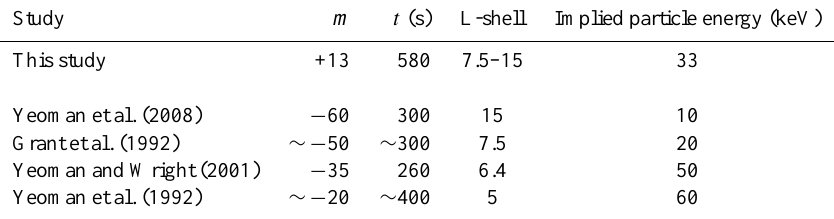
Table 1. A summary of the characteristics of this case study and previous ULF wave observations showing equatorward phase propagation, and the particle energy of their proposed magnetospheric source (after Yeoman et al., 2008). Study m t (s) L-shell Implied particle energy (keV) This study +13 580 7.5–15 Yeoman et al. (2008) − 60 300 Grant et al. (1992) ∼− 50 ∼ 300 Yeoman and Wright (2001) Yeoman et al.